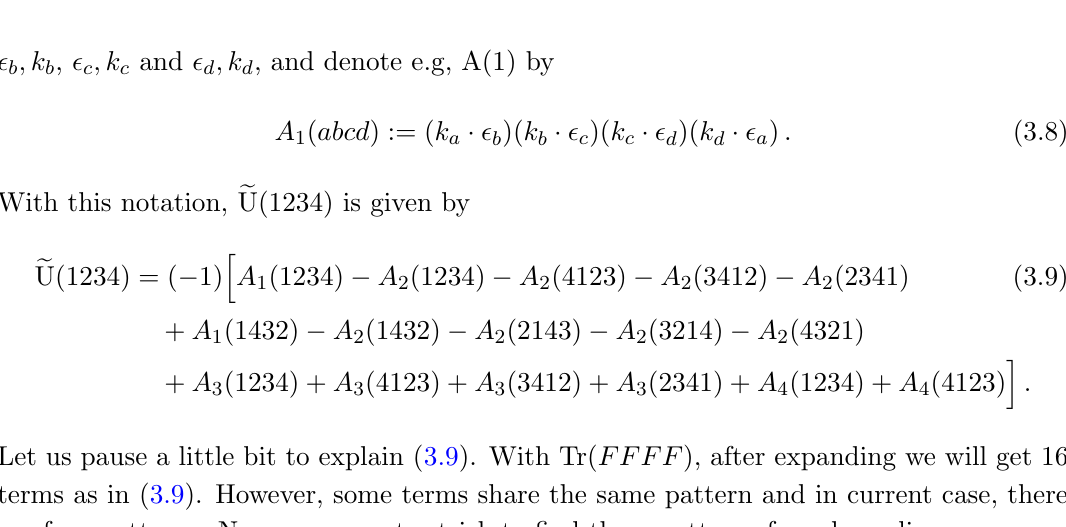
Figure 3 . All possible structures in the four-element